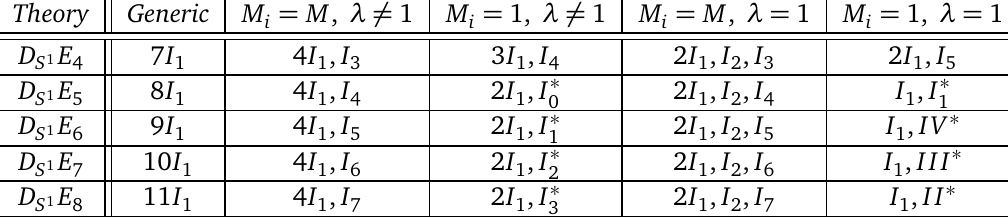
Table 12: Some M in the interior of the U -plane are